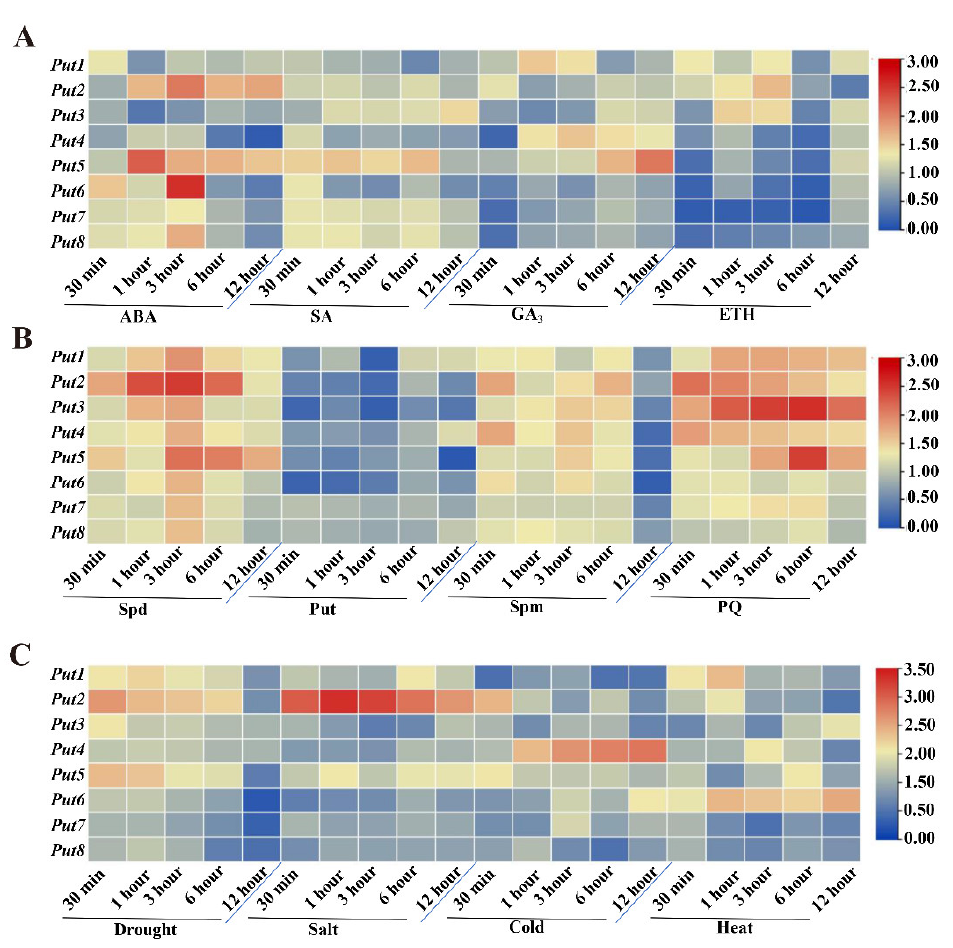
Figure 2. Expression patterns of Put genes in tomatoes under hormone, polyamine, paraquat, or abiotic stress. ( A ) Heatmap representation of the responsiveness of Put genes after treatment with ABA, SA, GA 3 , and ET. The scale (0 to 3) represents the expression level (from low to high). ( B ) Heatmap representation of the responsiveness of Put genes after treatment with Spd, Put, Spm, and PQ. The scale (0 to 3) represents the expression level (from low to high). ( C ) Heatmap representation of the responsiveness of Put genes after drought, salt, cold, and heat treatment. The scale (0 to 3.5) represents the expression level (from low to high). qRT-PCR was conducted after treatment, according to the methods section. The expression of WT at 0 min in the different treatments was set to 1.